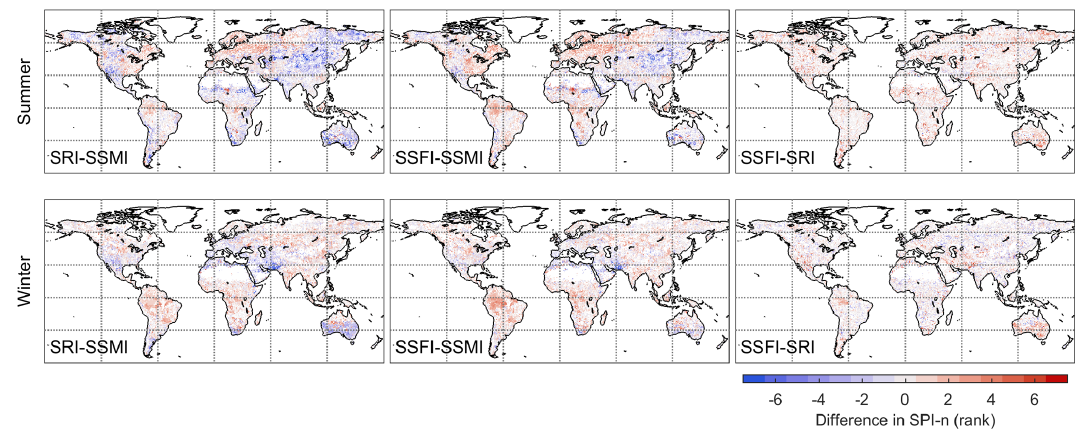
Figure 4. The difference in the rank of SPI-n for SRI and SSMI, SSFI and SSMI, and SSFI and SRI. Pixels where the difference between accumulation periods are not statistically significant ( p <0.05) are